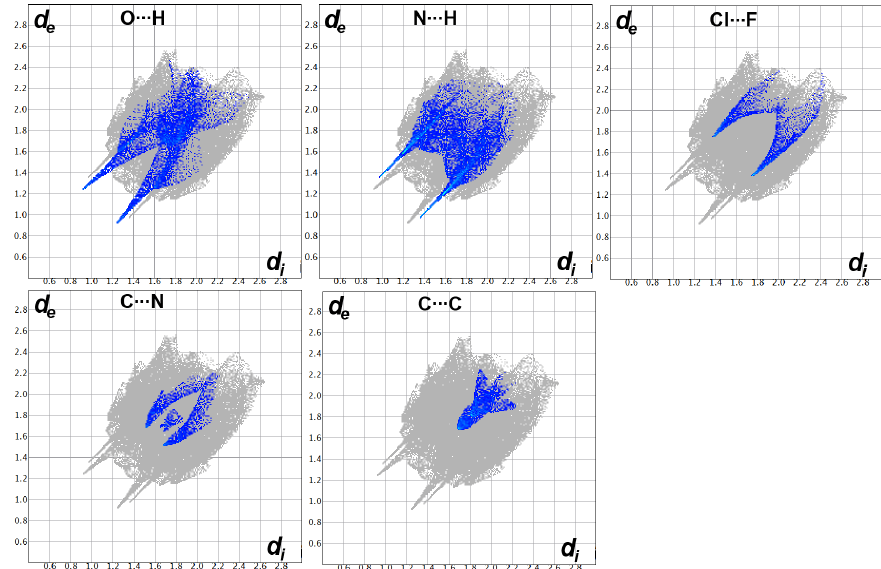
Figure 8. Fingerprint plots for the important contacts in free triazole ligand 3 .